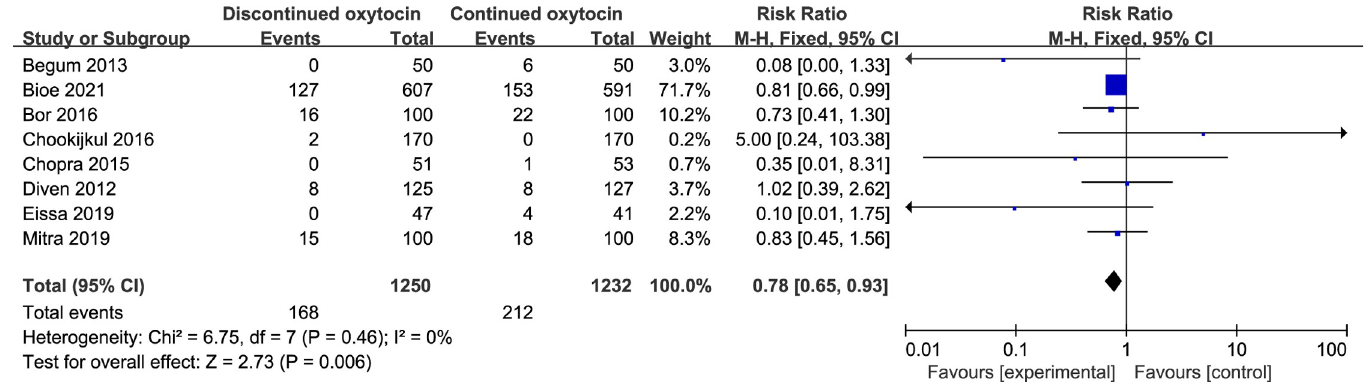
Fig 8. Pooled results for each outcome.